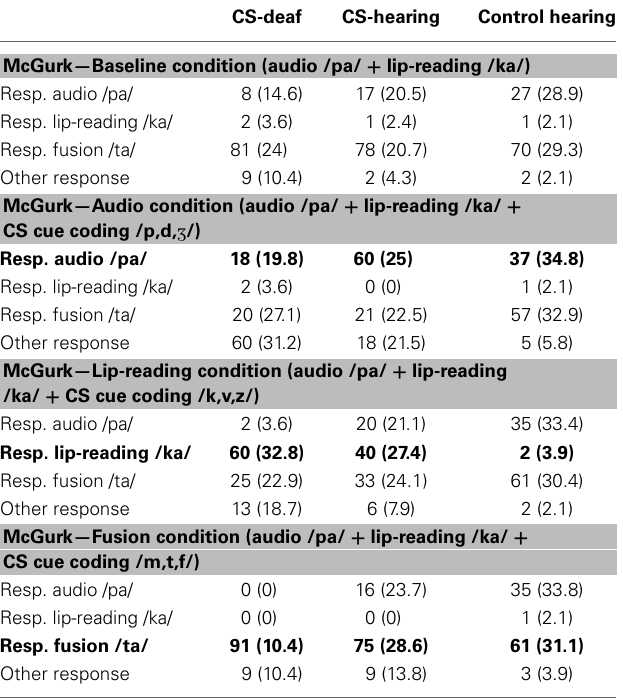
Table 7 | Mean percentages of each kind of response (audio, lip-reading, fusion and other) for all groups in incongruent